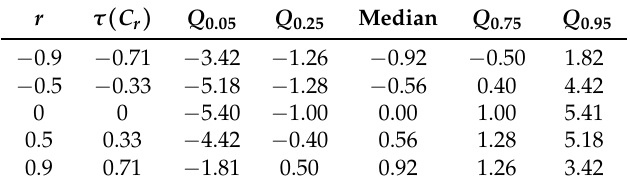
Table 3. Some percentiles of Y = X 1 / X 2 , where ( X 1 , X 2 ) follows Student- t Copulas, ν = 3.